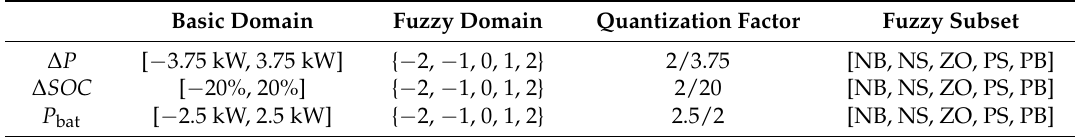
Table 1. Quantitative results of the input and output.